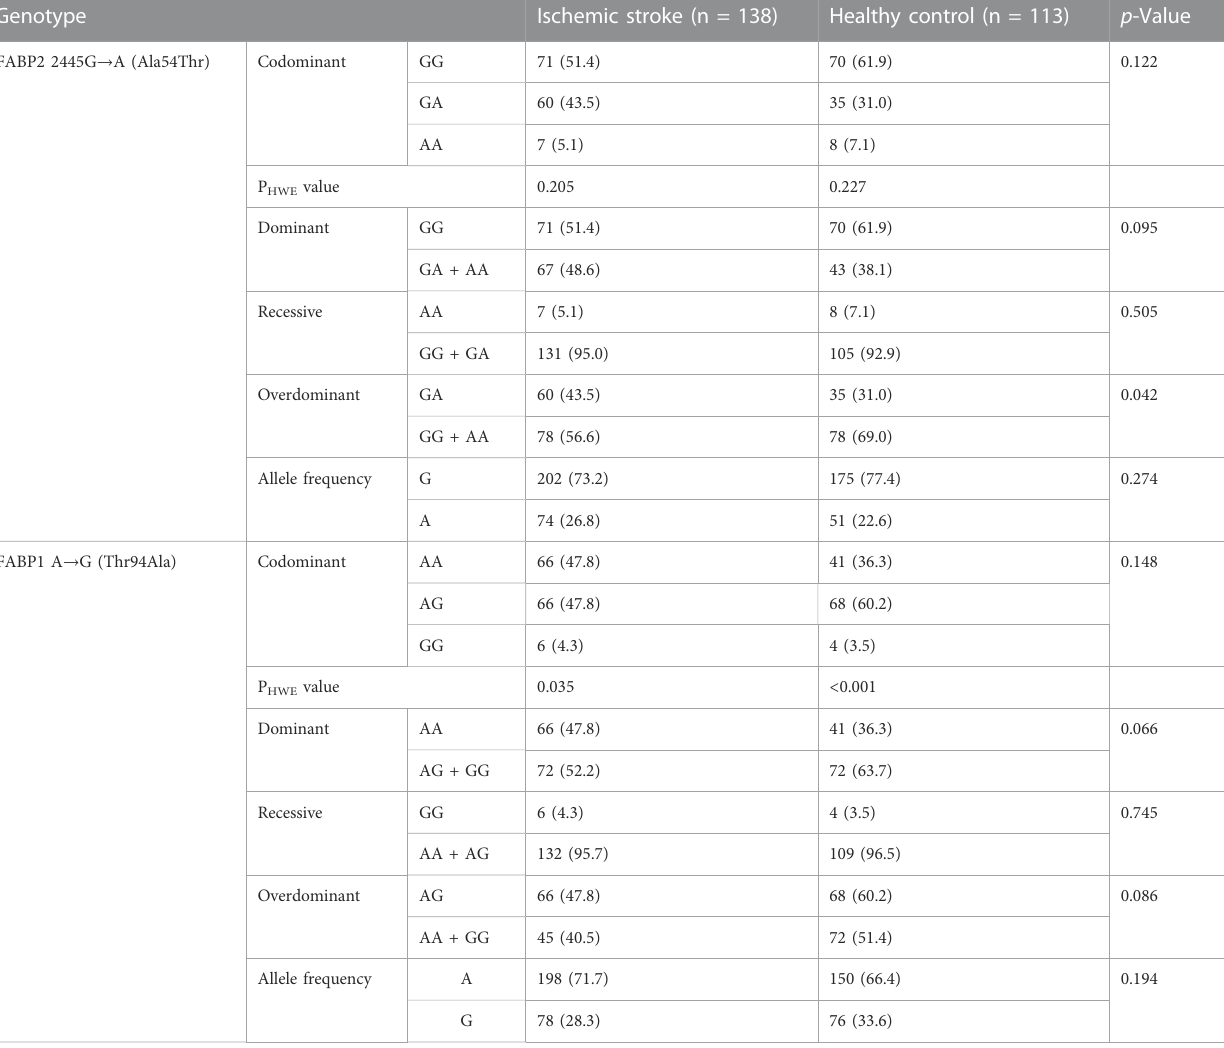
TABLE 2 Genotype frequency and Hardy-Weinberg equilibrium distribution of SNPs and mutation frequency of alleles.